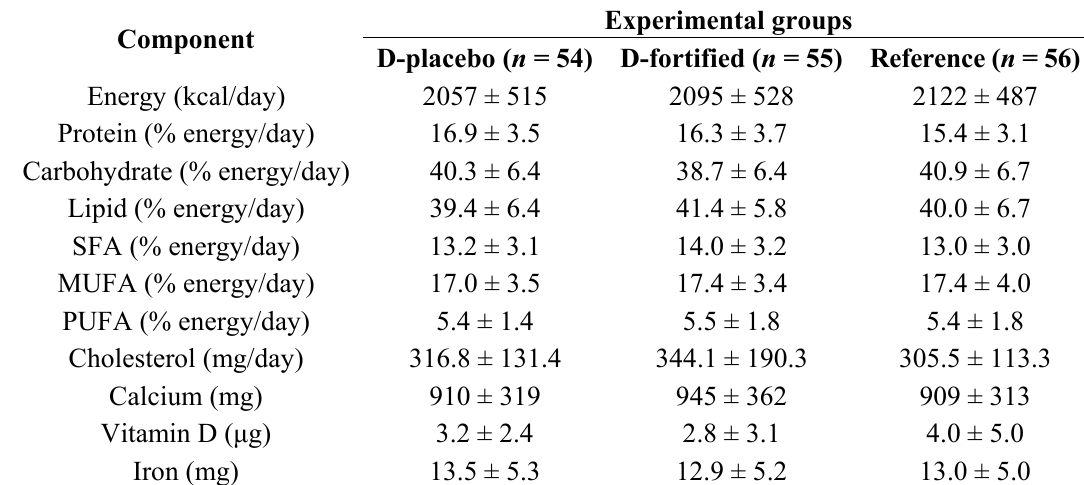
Table 2. Baseline energy, nutrient and cholesterol intakes of the three groups.